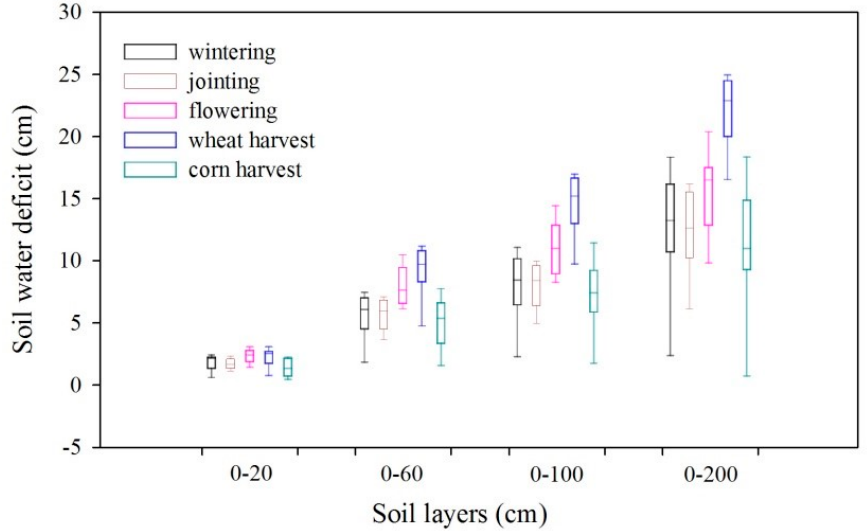
Figure 11. Soil water deficit at different crop growth stages in different soil layers under the S2 scenario of brackish water irrigation in the Hebei Low Plains study area in North China.